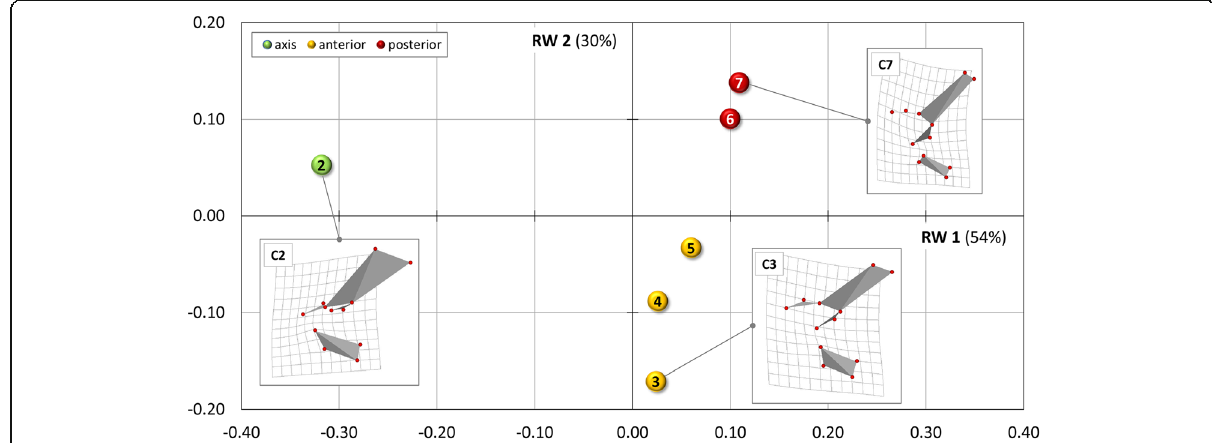
Fig. 2 Relative warps (RW) analysis results. The plot shows the shape differences of the cervical vertebrae along RW 1 and RW 2 for Mus musculus . Thin-plate splines (3D in left lateral view) visualize the variation between landmark configurations of the vertebrae from the mean shape (zero point). As confirmed by the cluster analysis, the morphological analysis allowed discrimination of the vertebrae in three different subunits (indicated by color